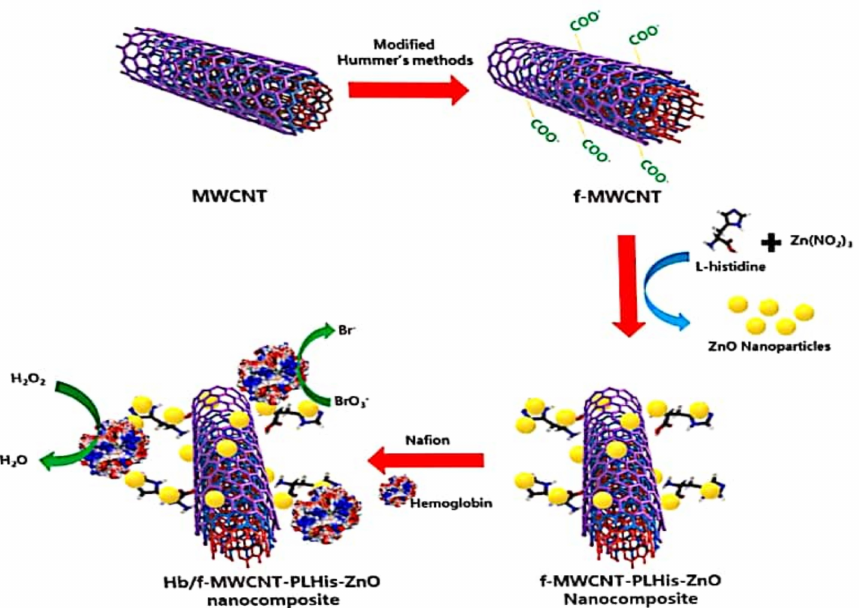
Figure 2. Schematic representation of the preparation of Hb/f-MWCNT–P-l-His–ZnO-modified elec- trode for the development of the bromate and H 2 O 2 biosensor (adapted from [38] with permission). Salimi and his group [39] presented another SWCNT, copper complex [Cu(bpy) 2 ]Br 2 and silicomolybdate immobilized onto glassy carbon (GC) electrode for electrochemical BrO 3 − detection. The fabrication of the electrode SiMo 12 O 404 − /[Cu(bpy) 2 ] 2+